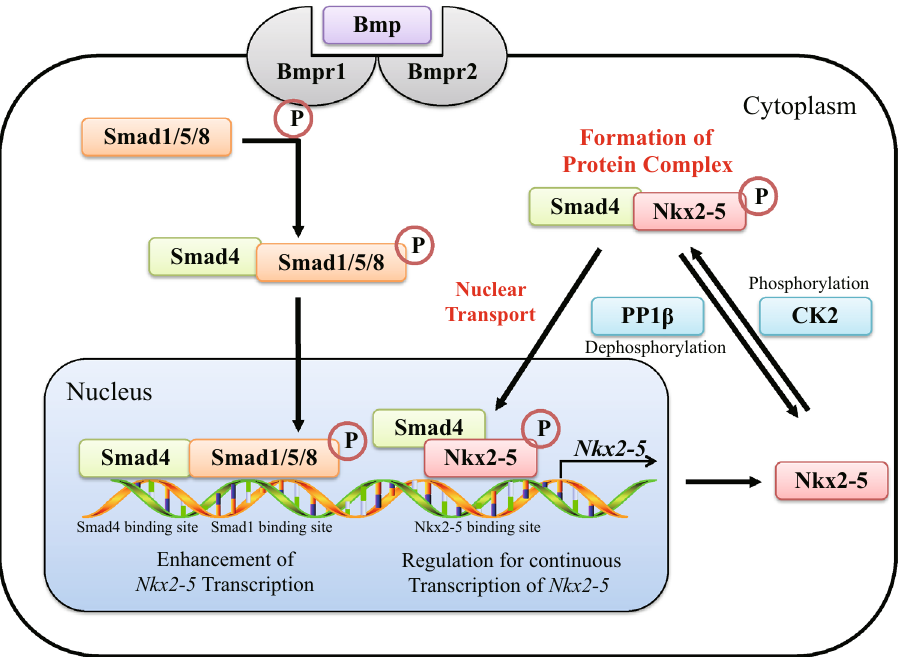
Figure 5. Schematic of Smad4 regulation of cardiac-specific gene expression and nuclear localization of Nkx2-5. Bmp activates its receptor, which then phosphorylates the Smad1/5/8 complex. In turn, the Smad1/5/8 complex binds to Smad4, which subsequently translocates into the nucleus to enhance Nkx2-5 transcription. Nkx2-5 protein is phosphorylated by CK2 and forms a protein complex with Smad4. This complex translocates into the nucleus and regulates Nkx2-5 transcription, thereby maintaining Nkx2-5 expression. Through this mechanism, Smad4 plays a decisive role in cardiac development and myocardial